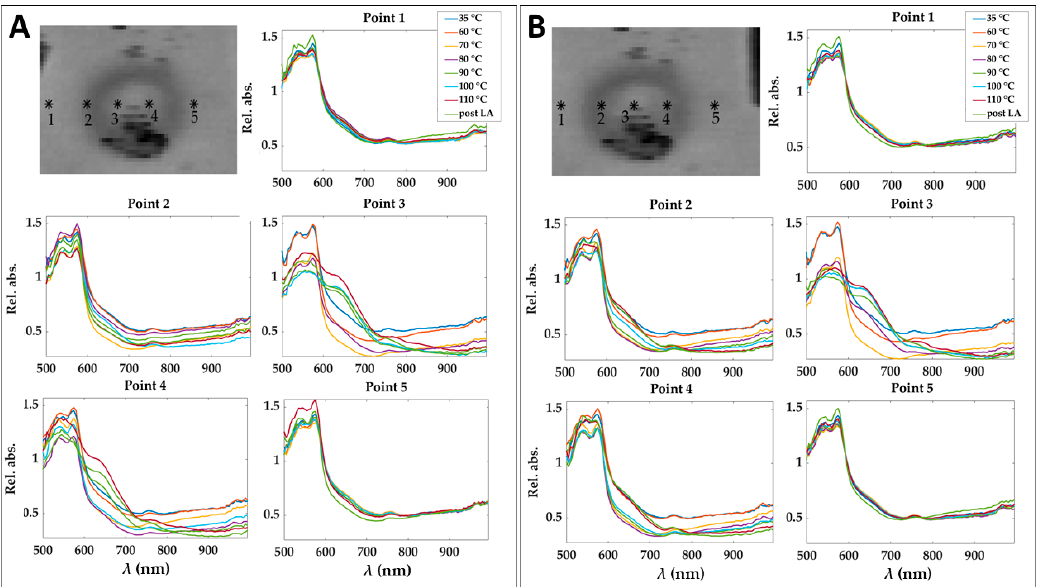
Figure 5. Spectra obtained for 5 pixels in the relative absorbance cubes for the eight acquisition times before ( A ) and after ( B ) applying motion compensation step. Pixels positions are shown before and after the correction of a cube acquired at 90 °C and for the image at 750 nm as an example. Results refer to Test 1.